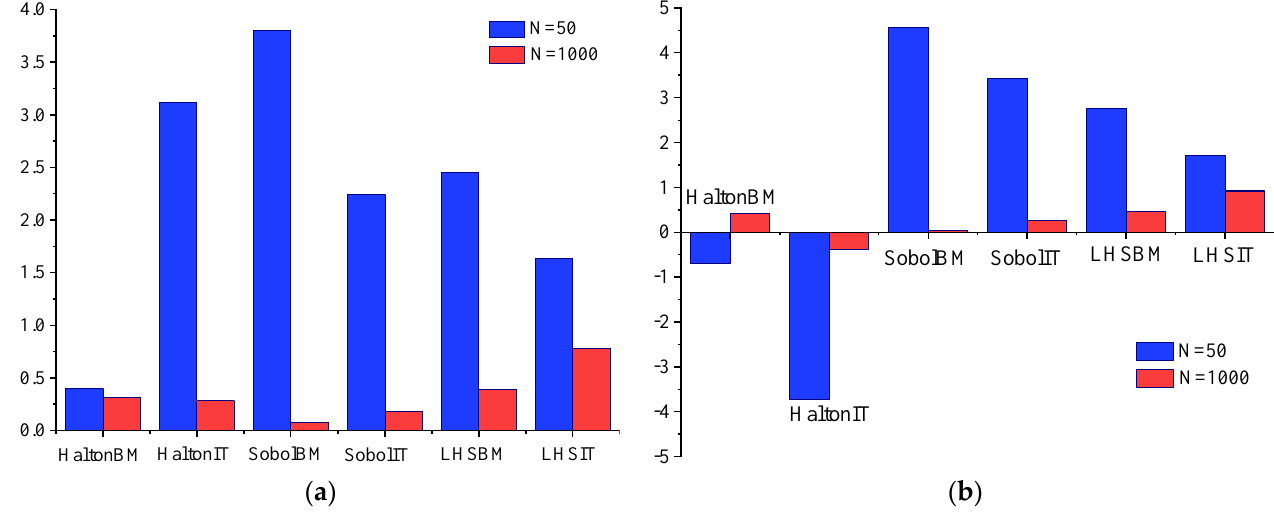
Figure 7. Maximum relative errors of sensitivity and failure probability when 𝑁 = 50 and 1000 in Example 3. ( a ) Maximum relative errors of sensitivity (%); ( b ) Maximum relative errors of failure probability (%)